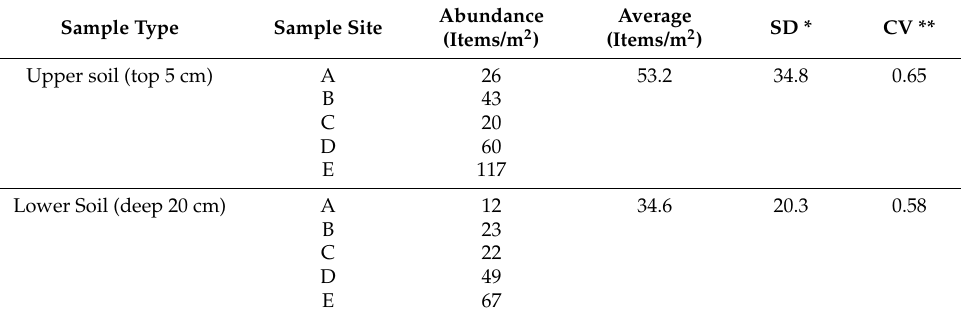
Table 3. Statistics of MPs abundance for different sample